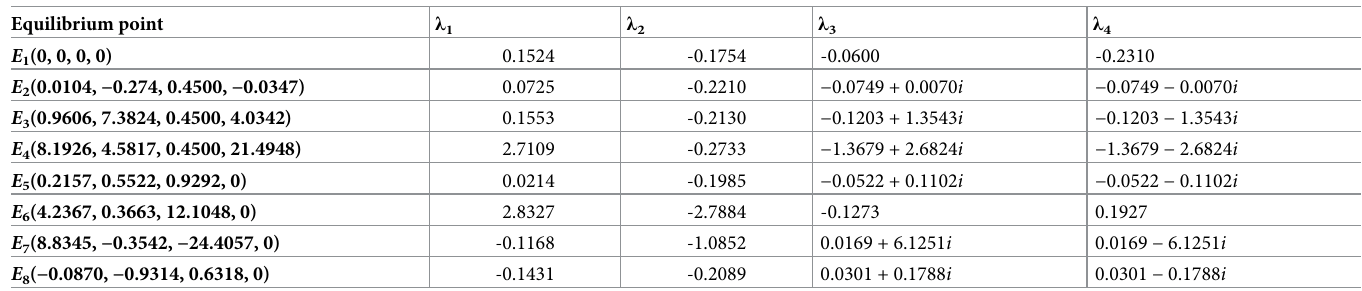
Table 1. Equilibrium points and their corresponding eigenvalues of Eq (5). Equilibrium